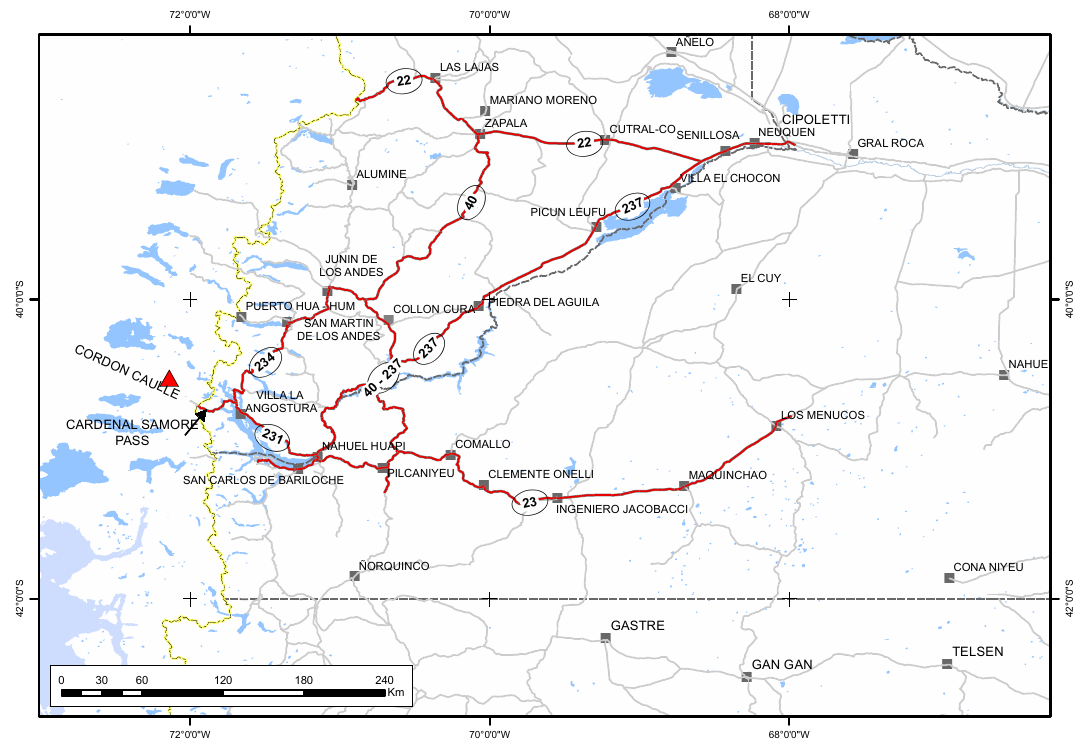
Figure 3. Map showing the main towns and the most affected road sections (red lines) in Neuquén and Río Negro provinces (Argentina) during the Cordón Caulle eruption. The black arrow indicates the international pass Cardenal Samoré